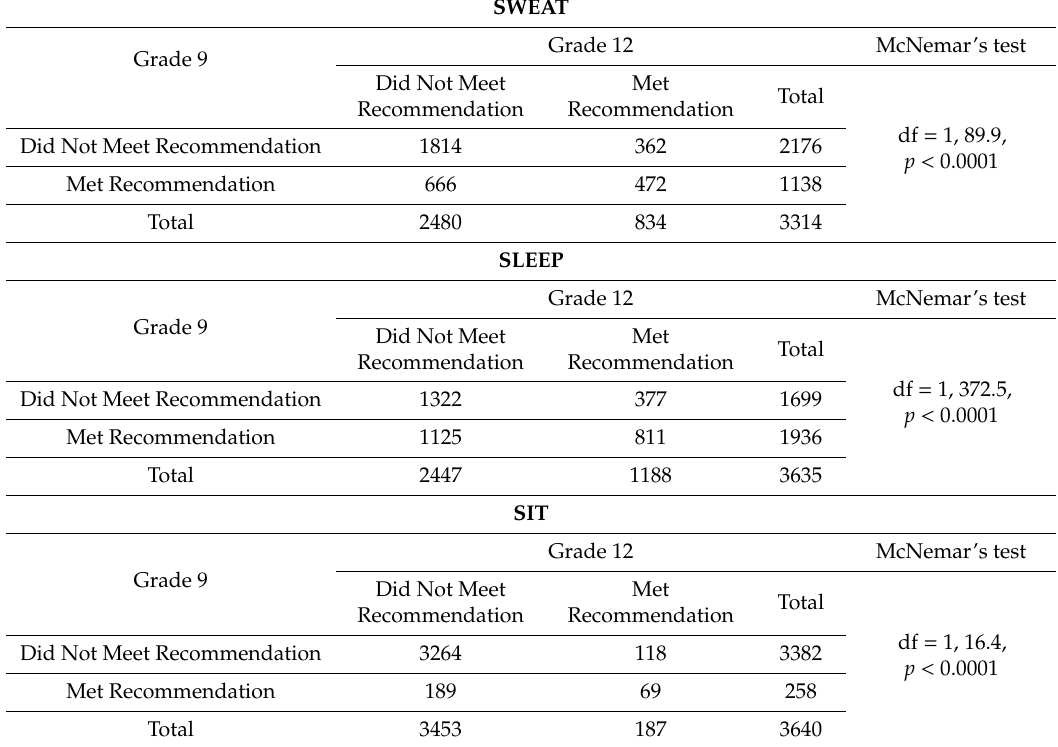
Table 4. Changes in students meeting the 24-Hour Movement Guideline recommendations over